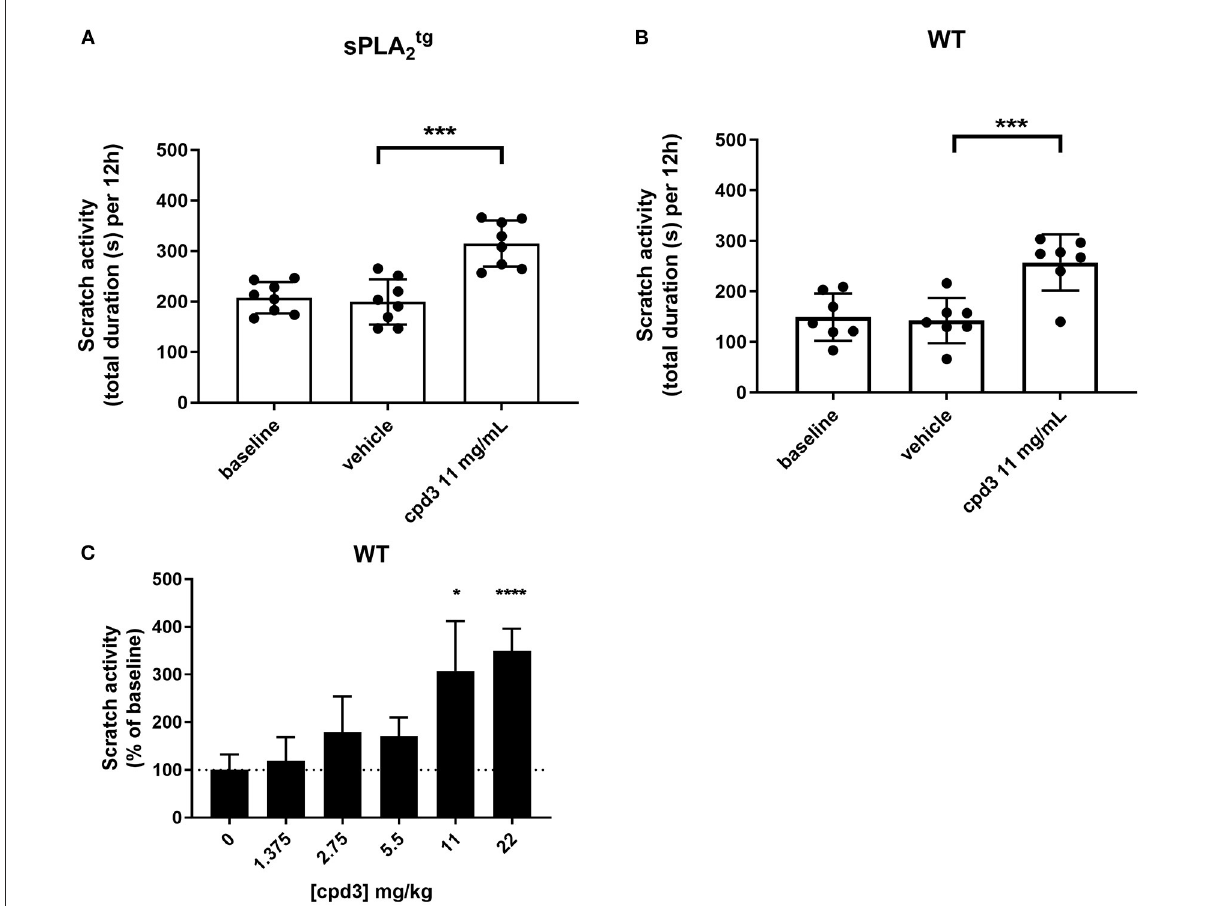
FIGURE5 Scratch activity (total duration in seconds per 12h, mean of four consecutive nights) in (A) sPLA tg 2 mice ( n = 8), (B) wild type ( n = 7), receiving oral gavage of vehicle and subsequently cpd3 (11 mg/kg) and (C) wild type ( n = 4 per group), during 12 hours after a single oral gavage of different doses of cpd3. Statistics: (A,B) paired t -test; *** p < 0.001, (C) paired t-test compared to baseline; * p < 0.05; **** p <